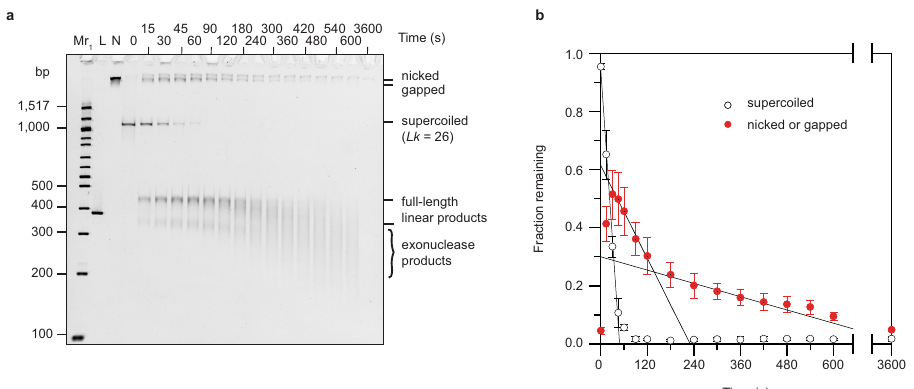
Fig. 1 Recognition and cleavage of exposed bases in supercoiled minicircle DNA by Bal-31. a 336 bp minicircle DNA ( Lk = 26; Δ Lk = − 6; σ = − 0.189) was incubated with Bal-31. At the times indicated, samples were removed, quenched by the addition of stop buffer, and analyzed by polyacrylamide gel electrophoresis. Mr 1 : 100 bp DNA ladder; L: linear 336 bp DNA (minicircle cleaved by EcoRV); N: nicked (336 bp minicircle nicked with Nb.BbvCI). b The fraction of supercoiled and nicked DNA in ( a ) was quanti fi ed. The assay was repeated three times and the mean values are shown. Error bars represent standard deviations; when not visible, they were smaller than the symbol. The disappearance of supercoiled substrate over time was fi t to a linear slope for the fi rst few timepoints only. Quantifying the disappearance of the nicked (and gapped) intermediates over the extended time course revealed multiphasic degradation kinetics. The disappearance of nicked DNA over time was fi t to two different linear slopes with the lines extrapolated to the axis limits to facilitate the comparison. Commercial preparations of Bal-31, as used in this assay, contain a mixture of “ fast ” and “ slow ” species of the enzyme 77 . The “ fast ” species generates a larger gap (~6 nucleotides) on average than the “ slow ” species (~3 nucleotides) 75 . The variation in gap sizes, with larger gaps, probably being cleaved more rapidly by Bal-31, likely explains the multiplicity of second-strand cleavage